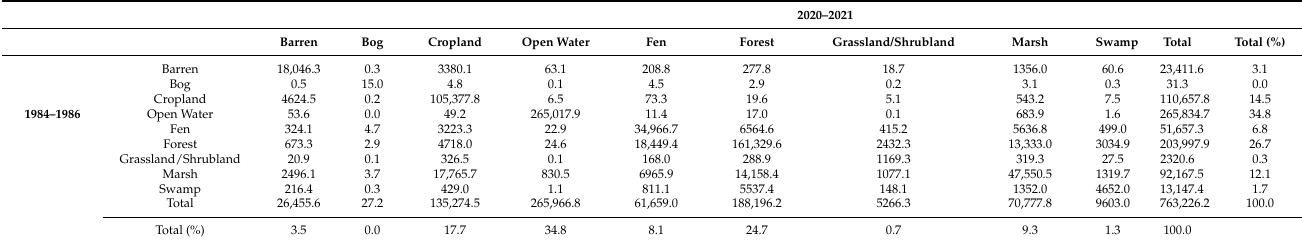
Table 4. The land cover transition between each class in the Great Lakes basin between the first (1984–1986) and the last (2020–2021) time